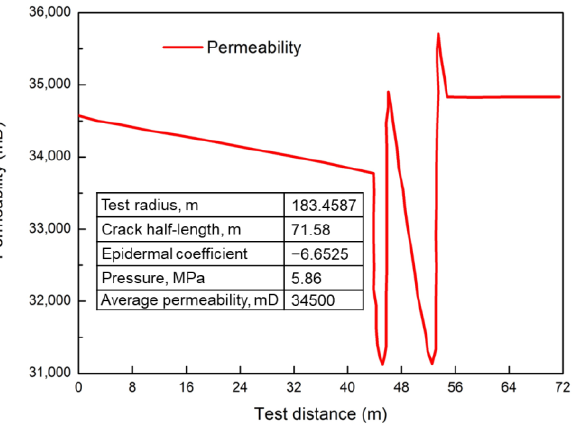
Figure 22. Dynamic fracturing crack pressure drop testing of graphene – foam – cement slurry frac- turing.